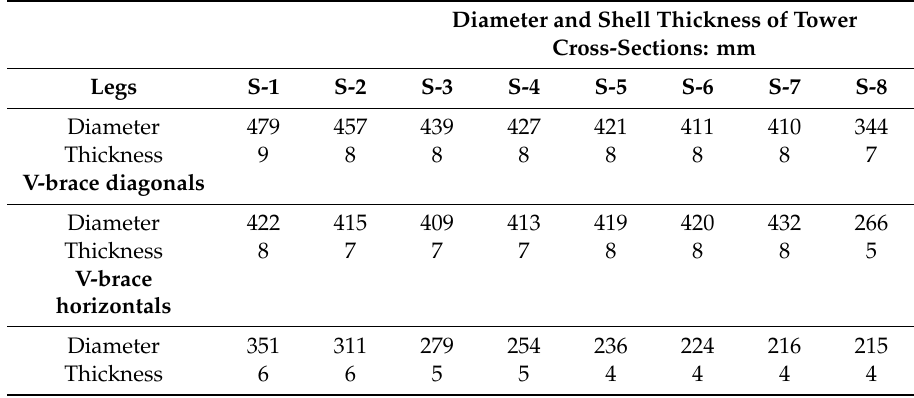
Table 4. Cross-section dimensions of 105 m lattice